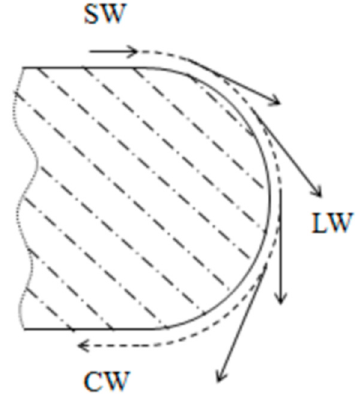
Figure 13. Types of waves on the surface of a complex shape.